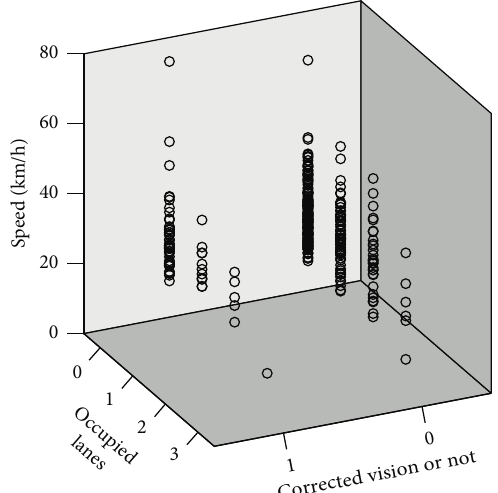
Figure 12: Relationship between eye vision, traveling speed, and illegal lane occupation